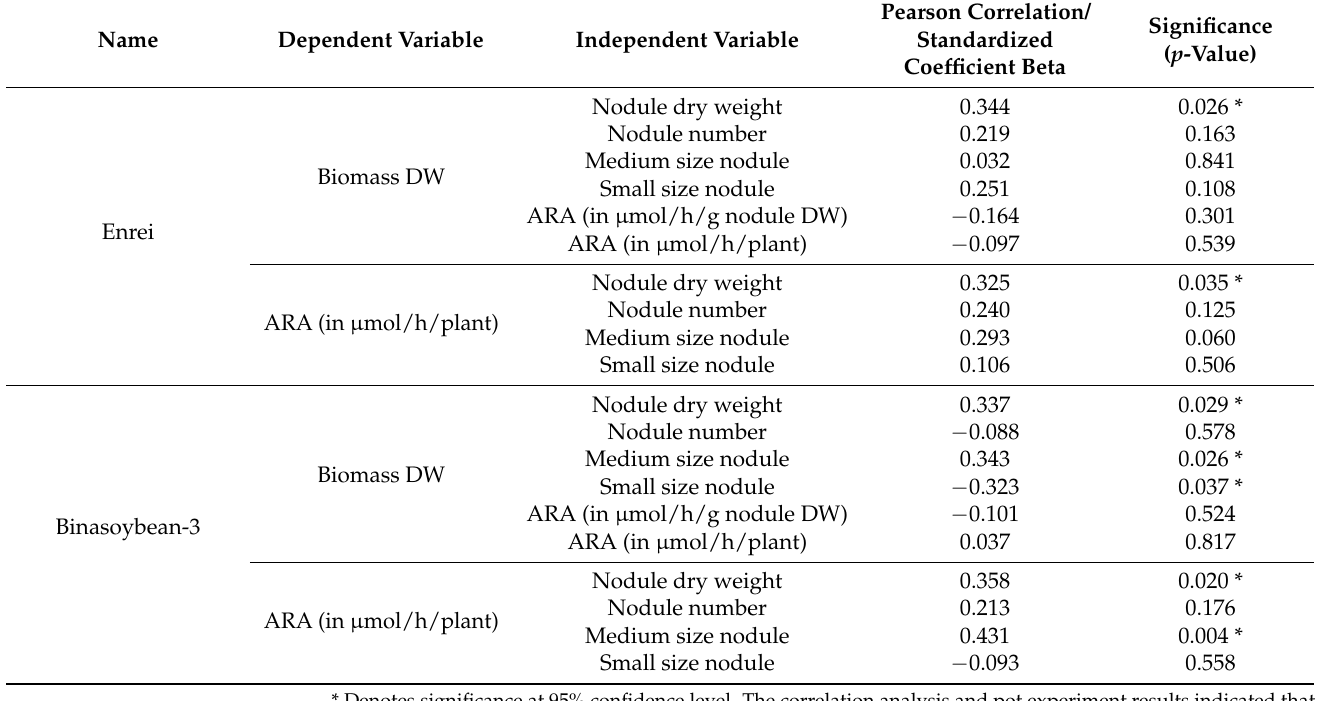
Table 6. Results of regression analysis of different parameters of pot